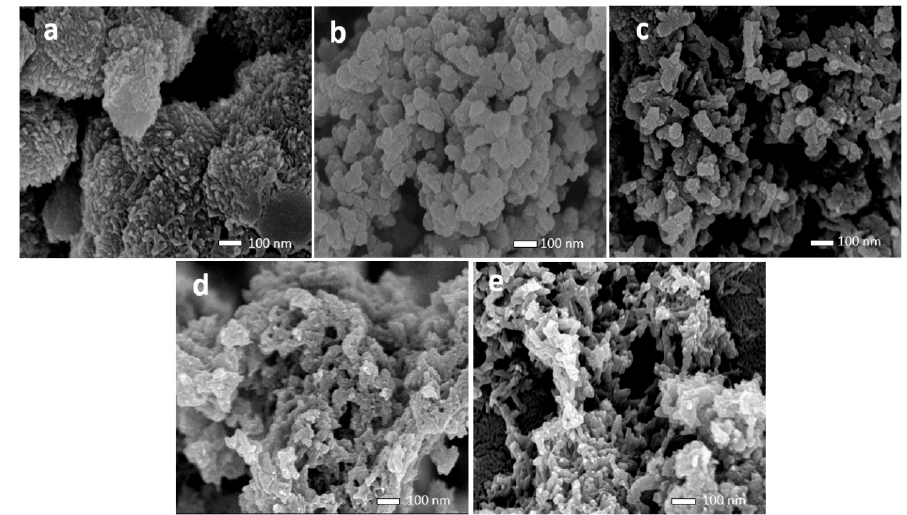
Figure 4. FESEM micrographs of ( a ) pure PAni, and PAni/MCC nanocomposite prepared from solutions containing different mass ratio of Ani/MCC of ( b ) 0.37/0.63; ( c ) 0.56/0.44; ( d ) 0.74/0.26; ( e ) 0.93/0.07.